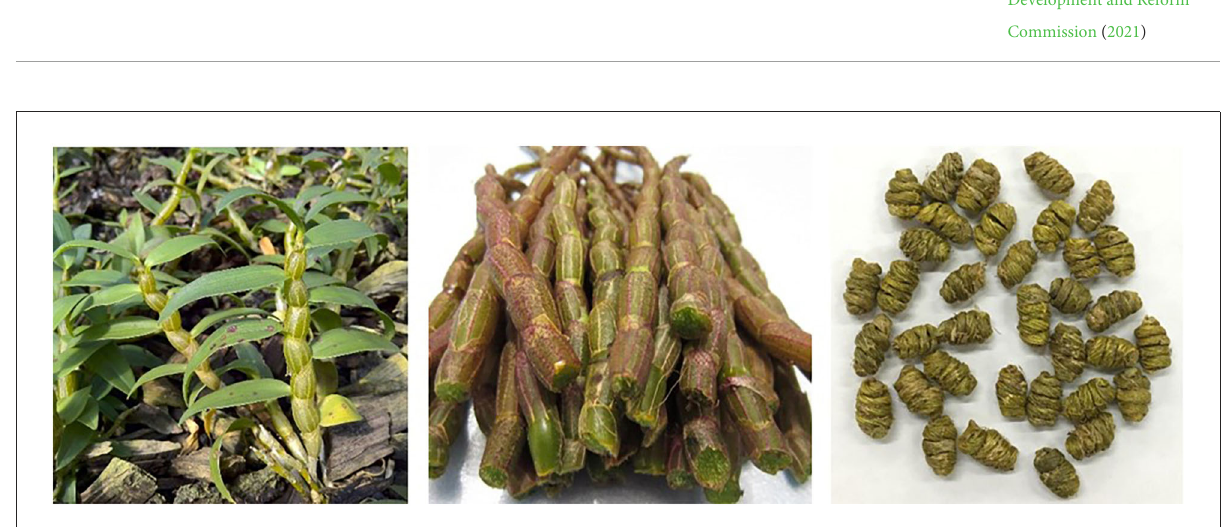
FIGURE1 Plants, stems and products of Dendrobium